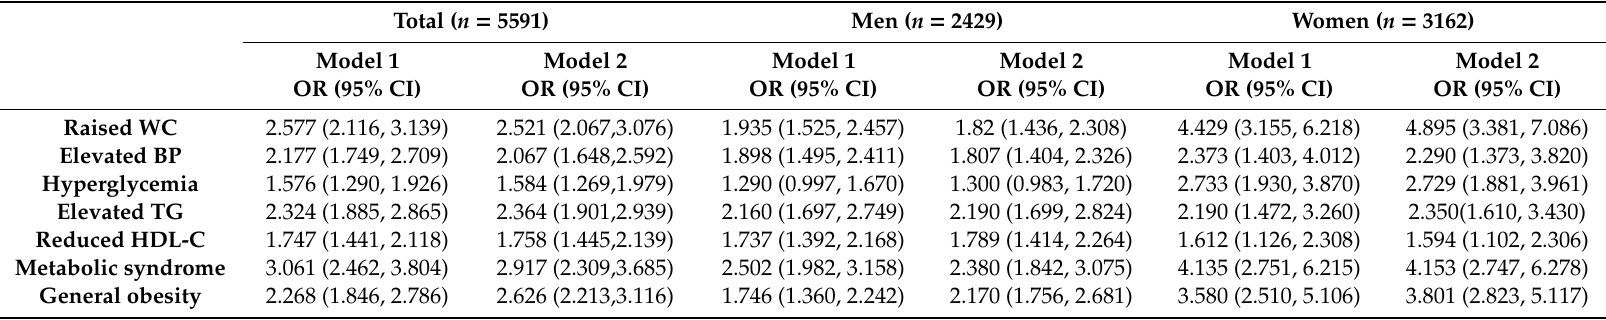
Table 3. Multivariate-adjusted odds ratios (OR) of the association of hyperuricemia with metabolic syndrome (MetS), various components of the metabolic syndrome, and general obesity (defined by a BMI ≥ 25 kg / m 2 ).